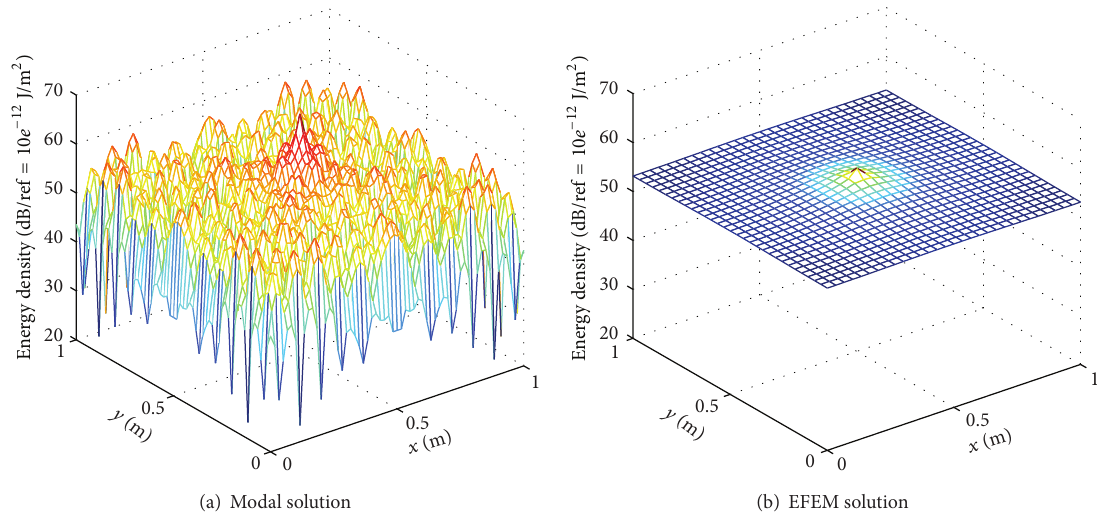
Figure 6: The energy density distributions of the plate in case 3 calculated by both modal superposition method and